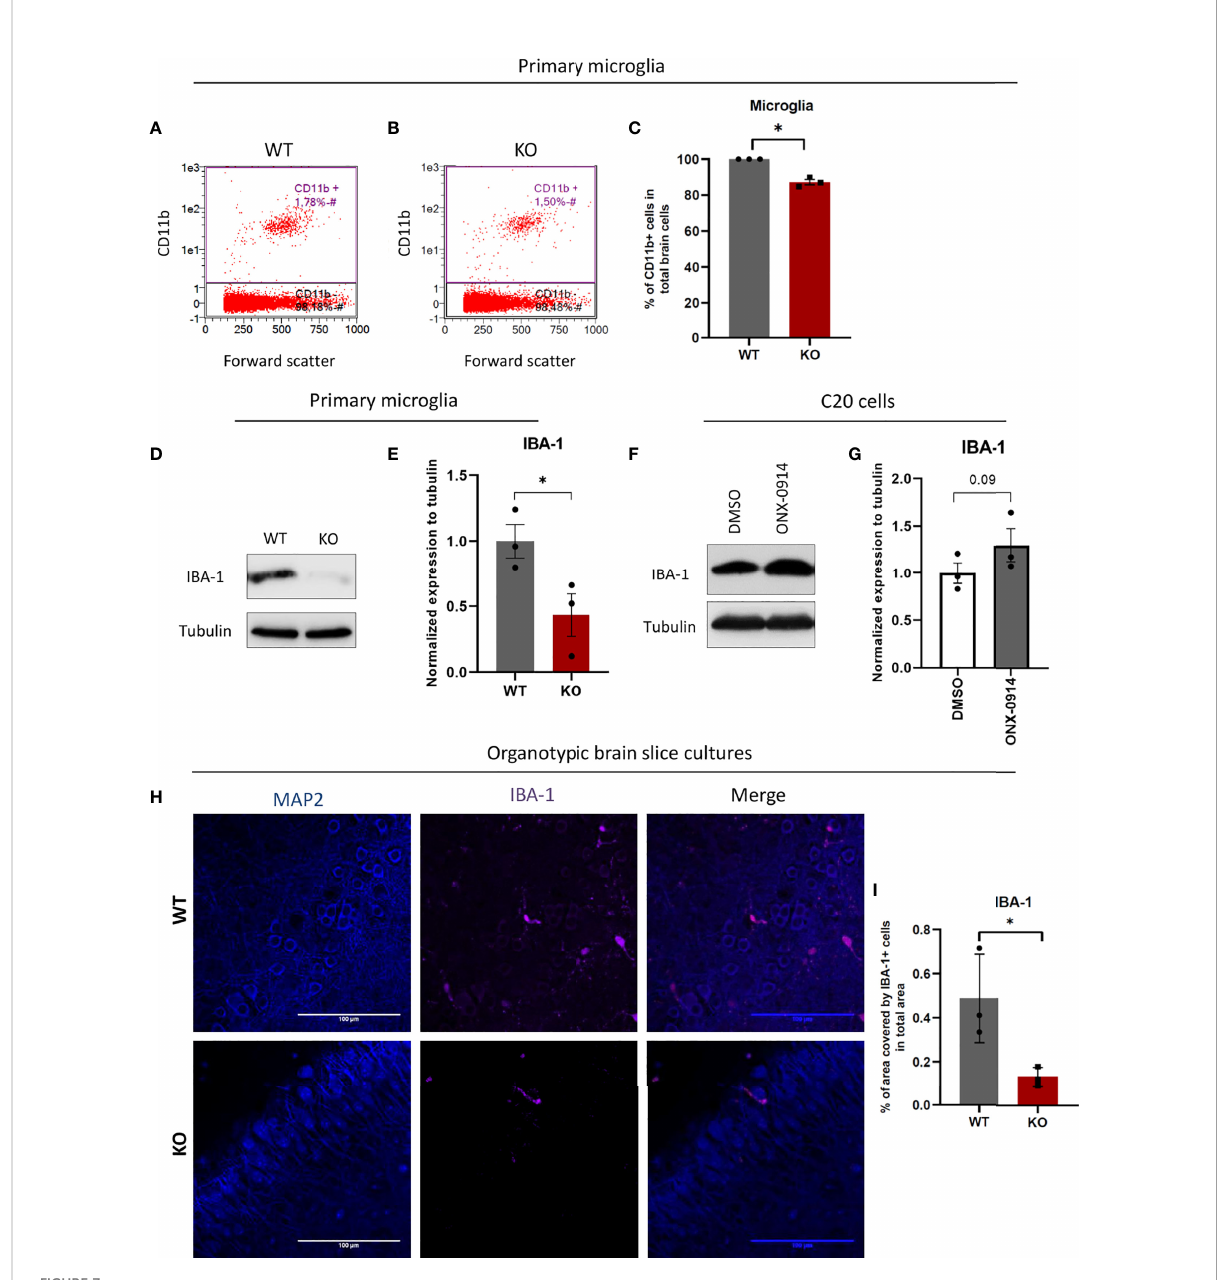
FIGURE 7 b 5i/LMP7 impairment results in less microglia population in mice brains and differs expression levels of microglial surface markers. After brain dissociation, cell suspensions were stained with CD11b FACS antibody to determine microglia amount in the brain by fl ow cytometry. (A – C) Flow cytometric analysis of CD11b+ cells in WT (A) and b 5i/LMP7 KO (B) mice brains, and comparison analysis of CD11b+ cells (C) . (D) Western blot analysis of ionized calcium-binding adapter molecule 1 (IBA-1) in primary microglia. (E) Quanti fi cation analysis of IBA-1 Western blot data from (D) . (F) Western blot analysis of IBA-1 in C20 cells treated with 200nM of ONX-0914 for 24h. (G) Quanti fi cation analysis of IBA-1 Western blot data from (F) . (H) Immuno fl uorescence microscopy analysis of MAP2 and IBA-1 in organotypic brain slice cultures from WT and b 5i/LMP7 KO mice brains. (I) Analysis of % area covered by IBA-1 + cells in total area. All data are given (n=3) by mean ± SEM; *: P <